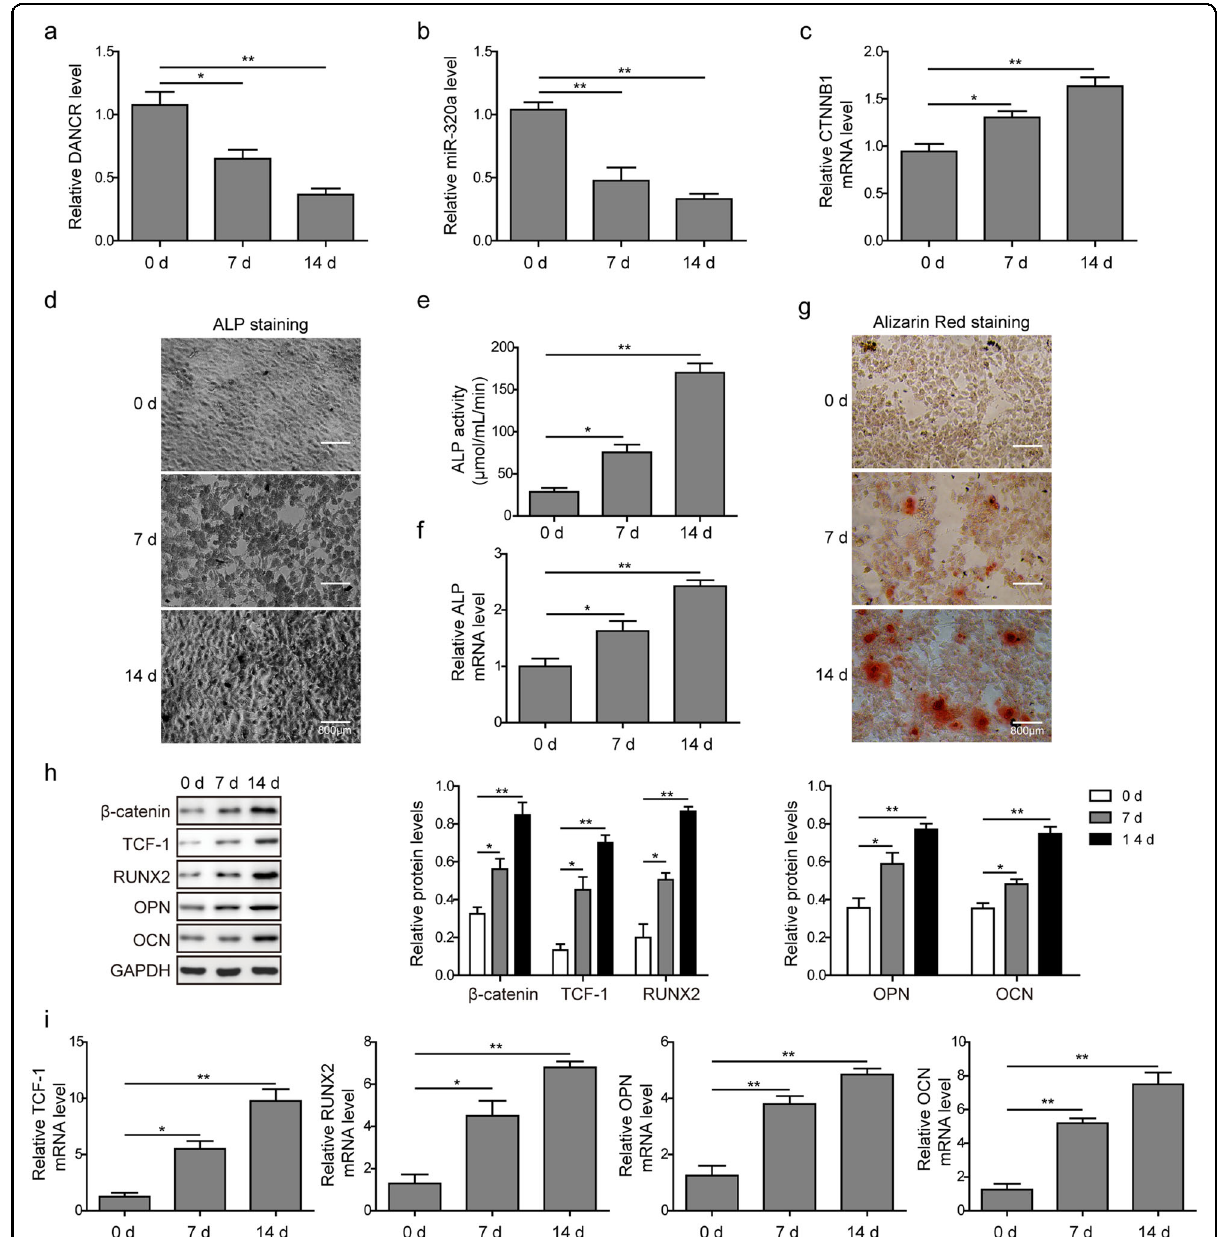
Fig. 2 The expression levels of DANCR, miR-320a, CTNNB1, and osteoblastic genes during osteogenic differentiation in vitro. BMSCs were incubated in osteogenic induction medium for 0, 7, and 14 days, and the relative expression levels of a DANCR, b miR-320a, and c CTNNB1 were determined by qRT-PCR. d BMSCs were stained with ALP and observed under a microscope. e , f ALP activity ( e ) and ALP mRNA expression ( f ) were determined upon induction of osteoblast differentiation. g Cells were stained with Alizarin Red and observed under an inverted microscope. h Expression of β -catenin, TCF-1, RUNX2, OPN, and OCN at the protein level was determined by western blot on days 0, 7, and 14 after osteogenic induction. GAPDH was used as a loading control. i Relative mRNA levels of TCF-1, RUNX2, OPN, and OCN during osteogenic differentiation were determined by qRT-PCR. All experiments were conducted independently at least three times. * P < 0.05 and ** P <